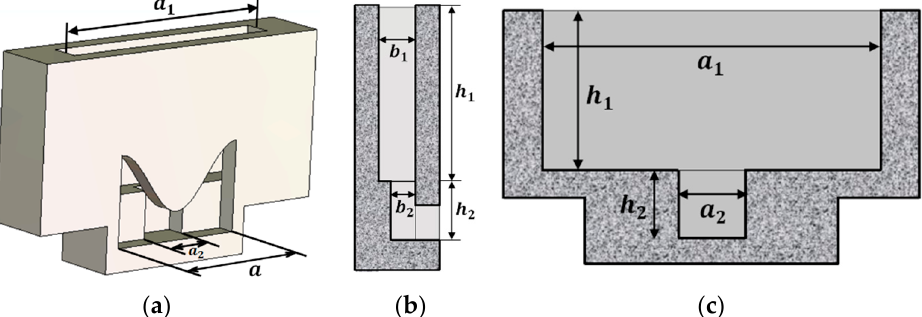
Figure 12. Schematic of the T-coupler: ( a ) 3D cut-away solid model, ( b ) front view of the T-coupler, and ( c ) cross-sectional view of the T-coupler.